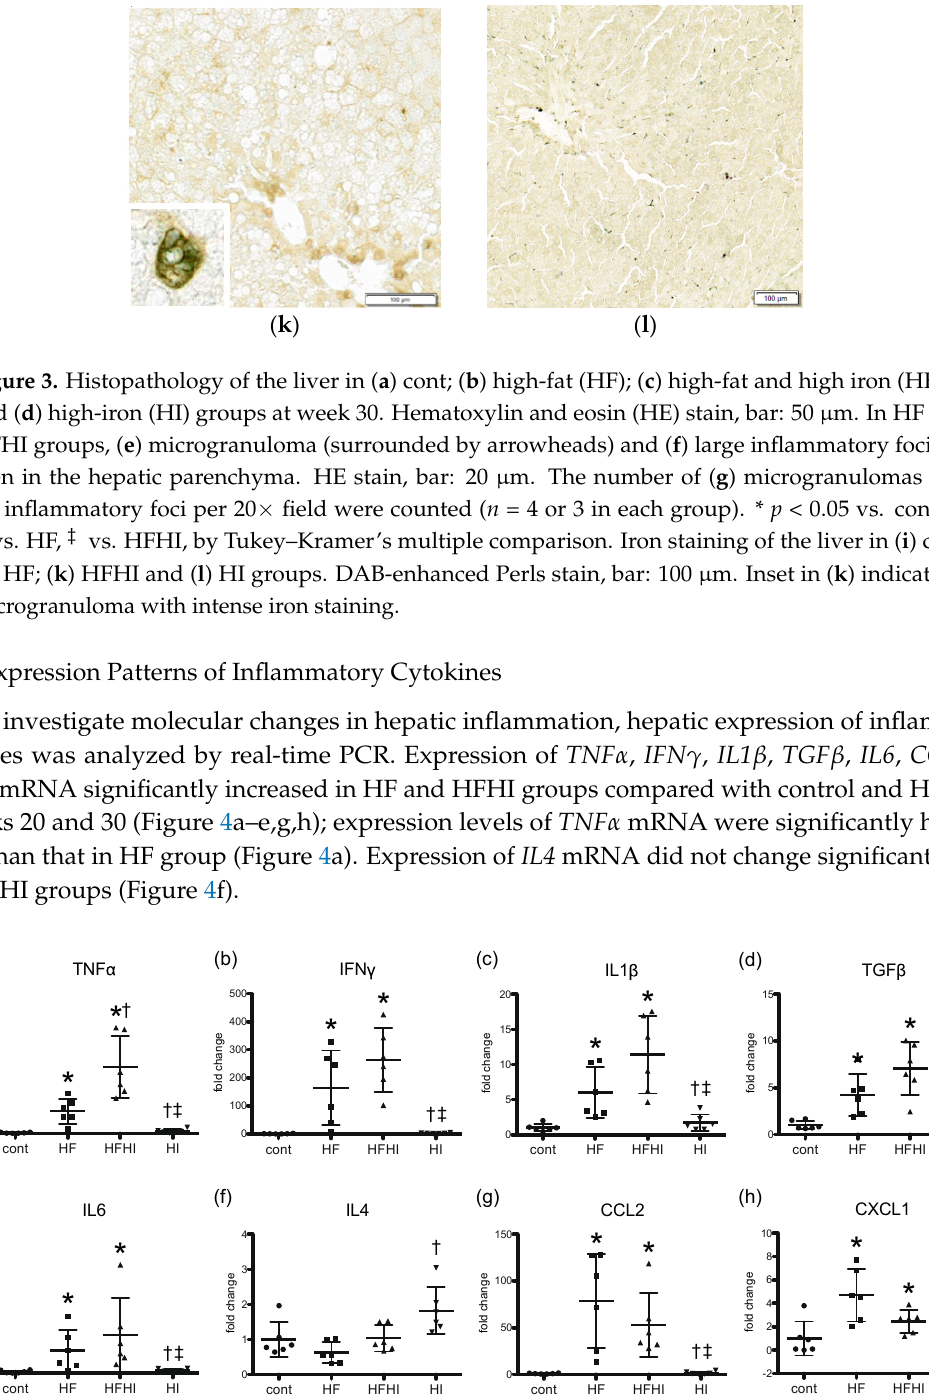
Figure 4. Hepatic expression of inflammatory cytokine and chemokine genes at weeks 20 and 30 ( n = 6 in each group). ( a ) TNF α ; ( b ) IFN γ ; ( c ) IL1 β ; ( d ) TGF β ; ( e ) IL6 ; ( f ) IL4 ; ( g ) CCL2 and ( h ) CXCL1 . Data were normalized to 18s rRNA and are expressed as fold change from control (mean ± standard deviation). * p < 0.05 vs. control, † vs. HF, ‡ vs. HFHI, by Tukey ‐ Kramer’s multiple comparison.